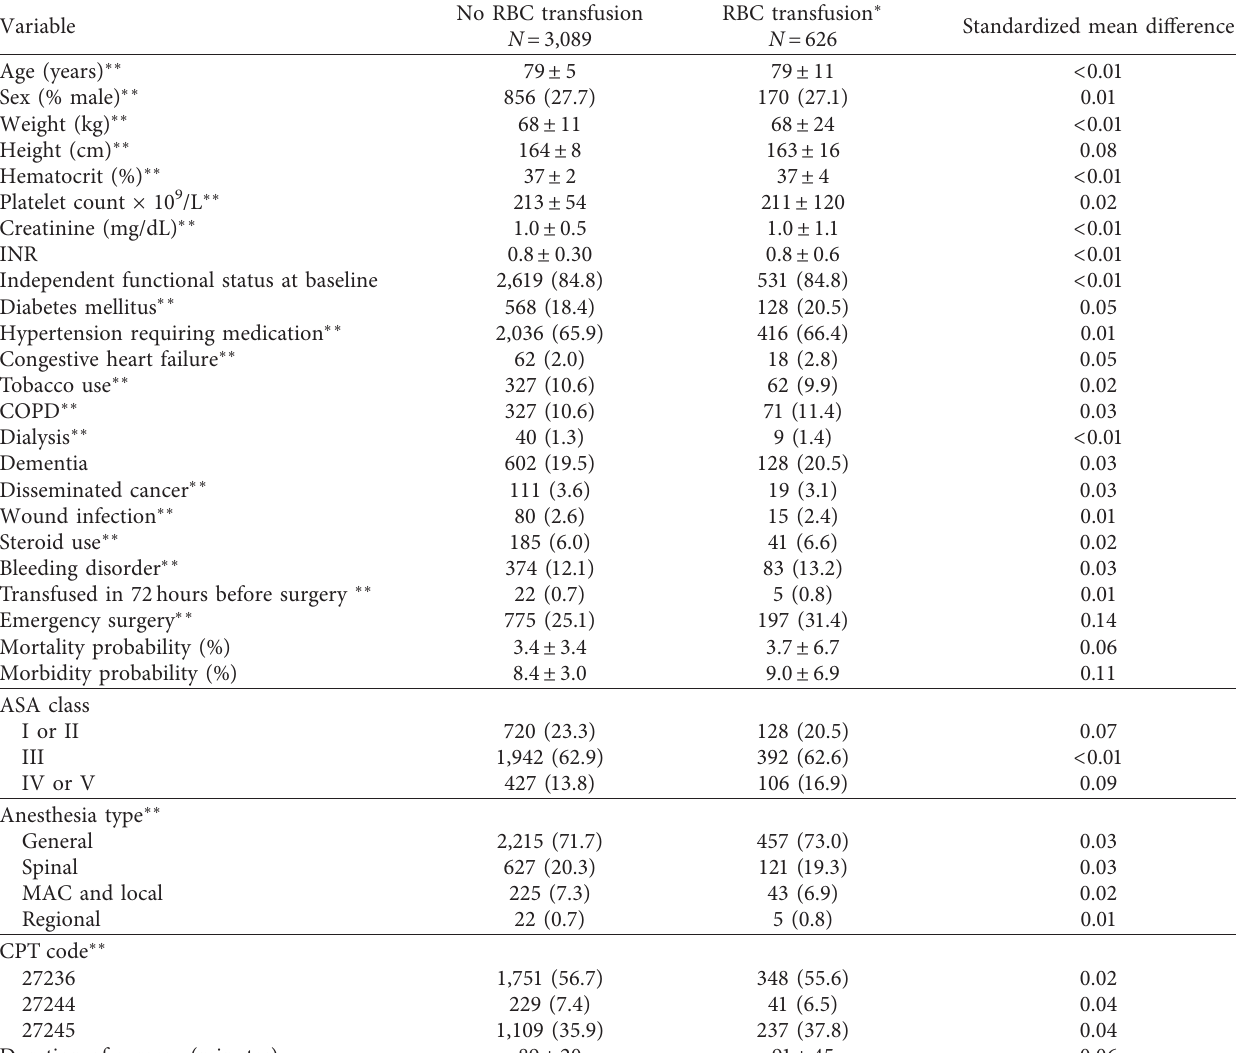
Table 3: Characteristics of patients in IPTW